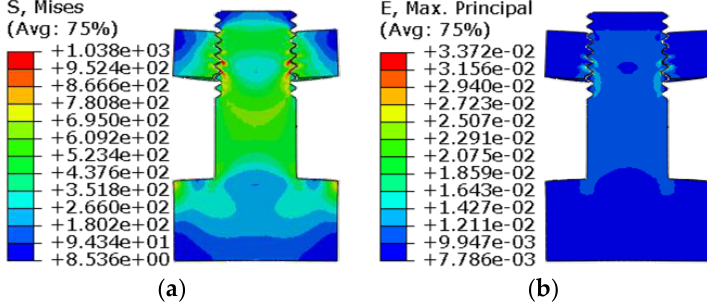
Figure 13. Von Mises equivalent stress and the maximum principal strain contours of the bolt and nut under the action of the maximum tension for condition 1: ( a ) Von Mises equivalent stress; ( b ) maximum principal strain.